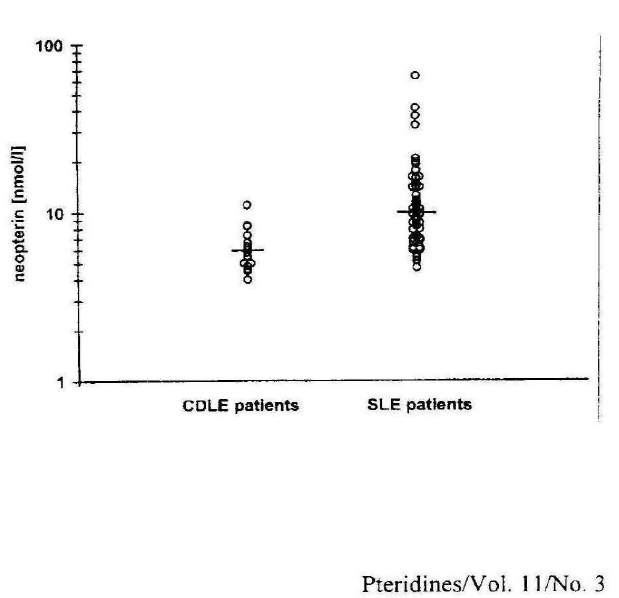
Fig. 2: Comparison of serum neopterin between CDLE and SLE patients. Serum neopterin concentrations were measured in CDLE (n = 16) and SLE (n = 49) patients. Horizontal lines indicate median values. Differences were significant according to the Mann-Whitney U test (P-value <